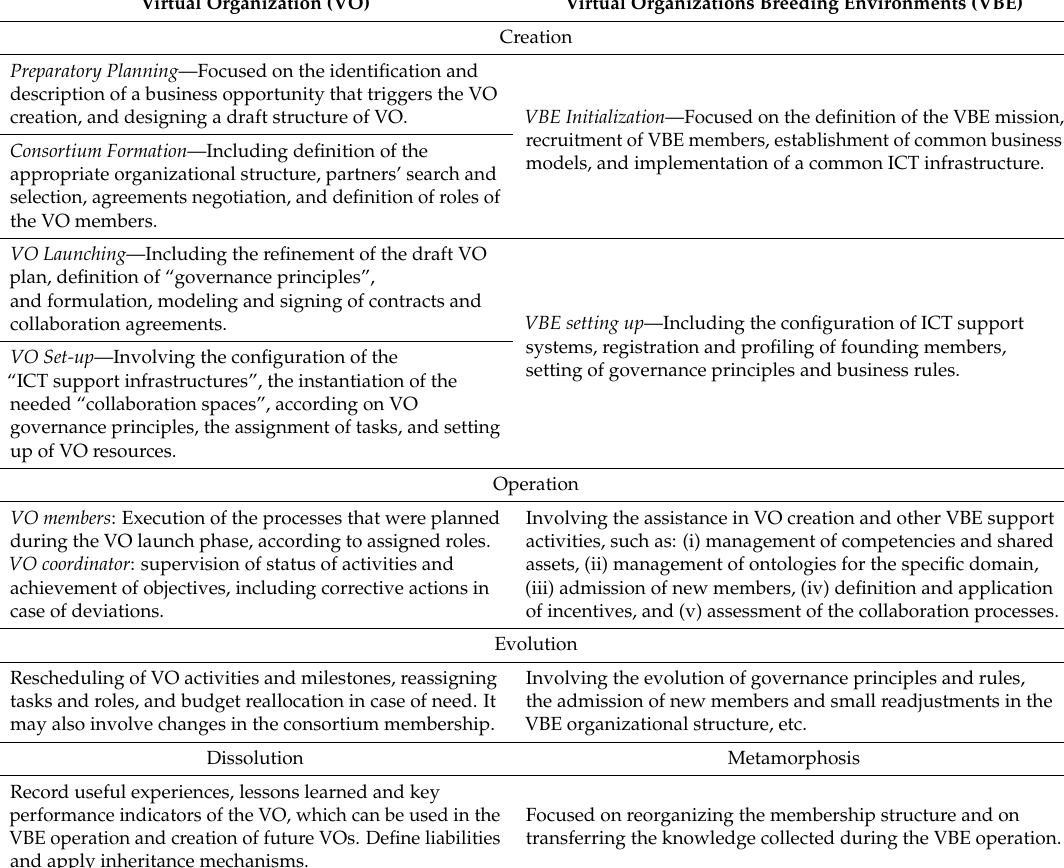
Table 1. Virtual organizations breeding environments (VBE) and virtual organization (VO) life-cycle